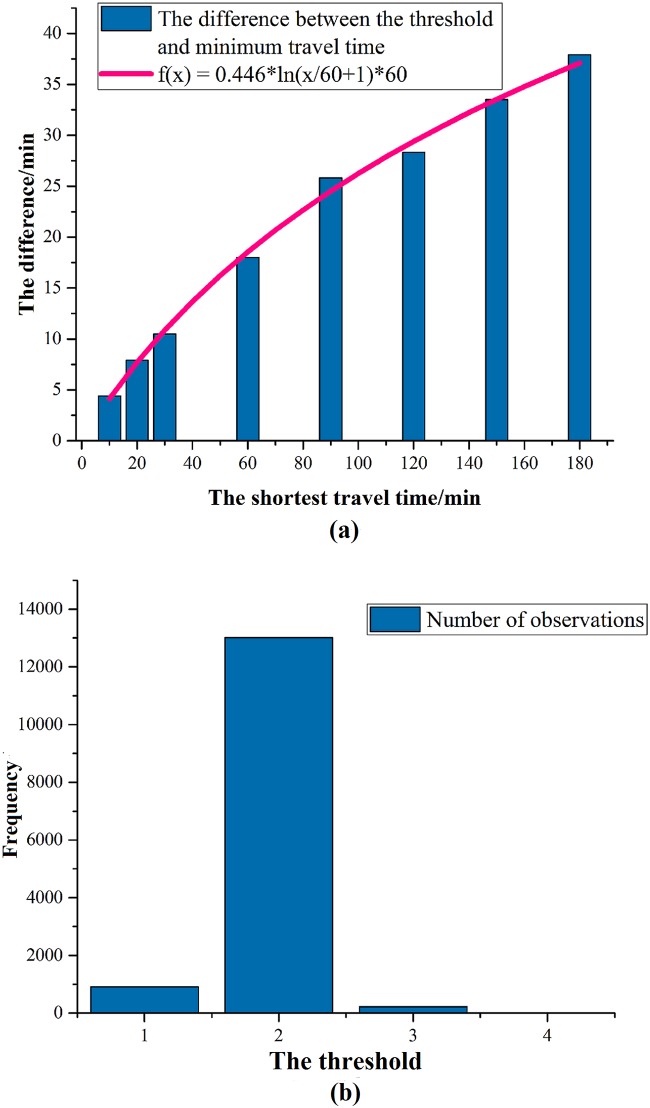
The thresholds of travel time and number of transfers.The figure displays the survey data associated with thresholds. By fitting, the parameters in the thresholds can be estimated.